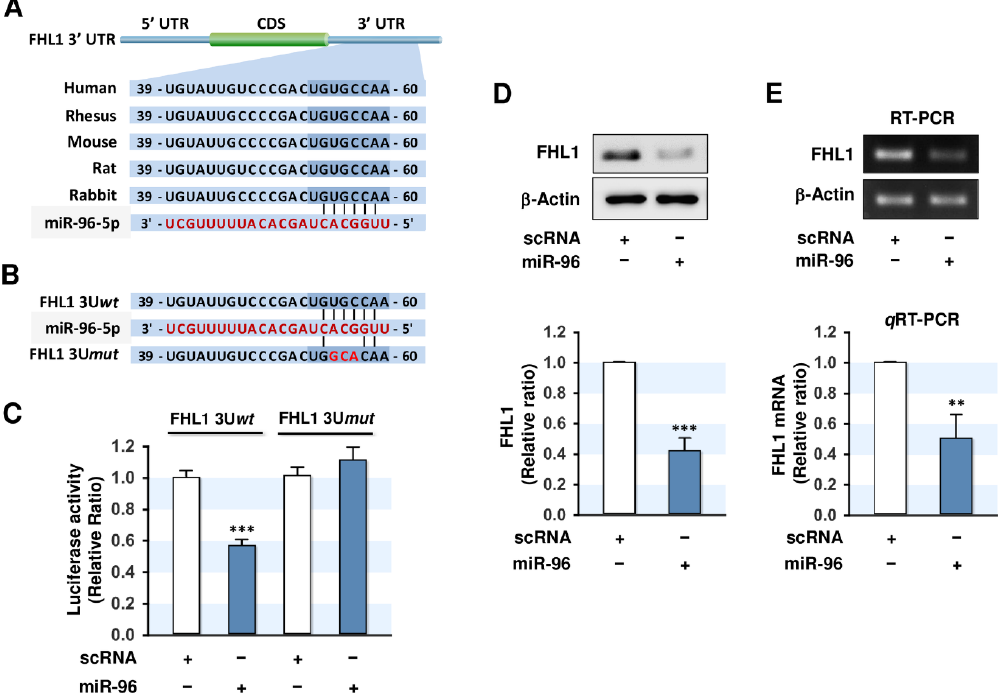
Figure 3. MiR-96-5p directly targets the 3’UTR of FHL1 and reduces FHL1 expression. ( A ) Sequence alignment of the 3’UTR fragments of FHL1 with miR-96-5p. ( B ) Sequences of the wild-type (FHL1 3U wt ) and mutant (FHL1 3U mut ) of FHL1 3’UTRs. ( C ) Luciferase reporter assays using scRNA or miR-96-5p cotransfected with a segment of wild-type (FHL1 3U wt ) or mutant (FHL1 3U mut ) FHL1 3’UTR in pmirGLO vectors. ( D ) Immunoblot analysis of FHL1 at 24 h after transfection with the 100 nM of scRNA control or miR-96-5p mimic. ( E ) RT-PCR (upper) and q RT-PCR (lower) analysis of FHL1 expression at 24 h after transfection with 100 nM of scRNA control or miR-96-5p mimic. The level of expression was normalized to the amount of β -Actin. The values are expressed as the relative ratio, where the intensity of normalized scRNA control was set to one. Results are expressed as means ± SEMs ( n > 3). **, p < 0.01; ***, p < 0.001 vs. scRNA.